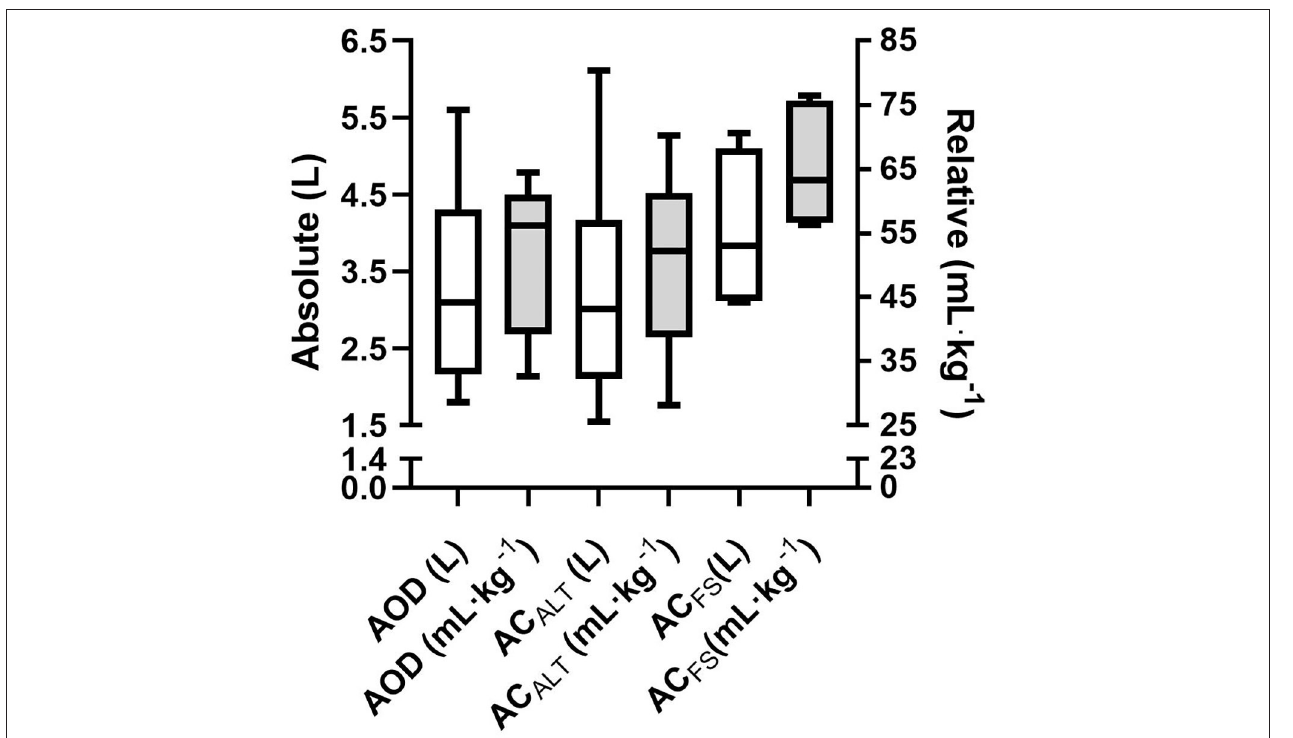
FIGURE 5 | Mean and standard deviation of absolute (white bar) and relative (gray bar) of AOD, AC ALT , and AC FS